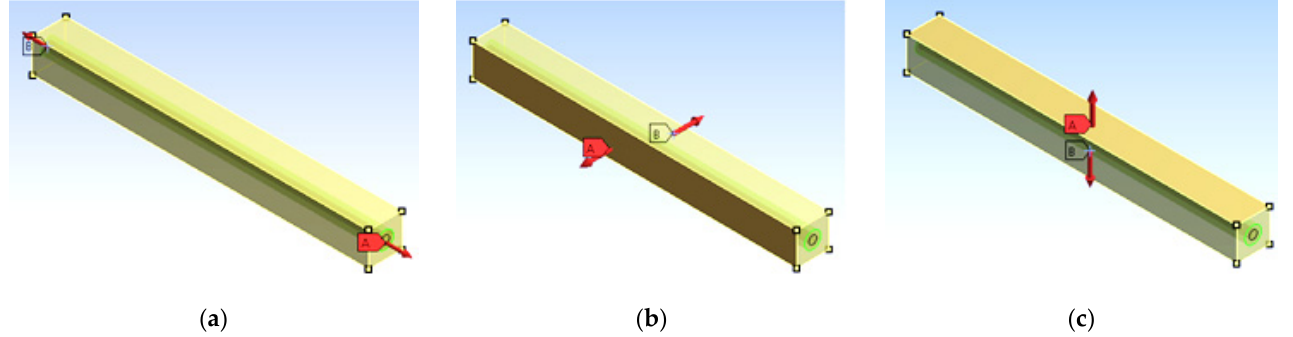
Figure 3. RVE under longitudinal ( a ) and transverse ( b , c ) loading. (Red arrows represent the loading